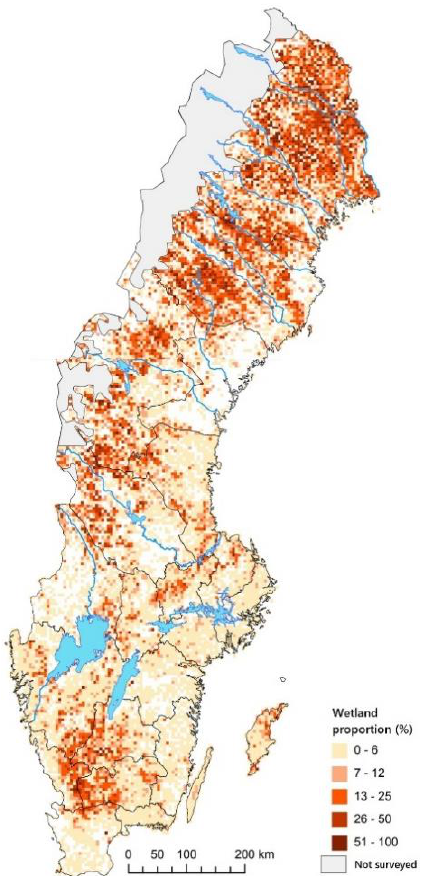
Figure 1. Wetland distribution in Sweden [20]. Reproduced from publicly available national report for wetland inventory in Sweden entitled “The Swedish Wetland Survey”; published by Swedish Environmental Protection Agency (Naturvårdsverket), 2014.